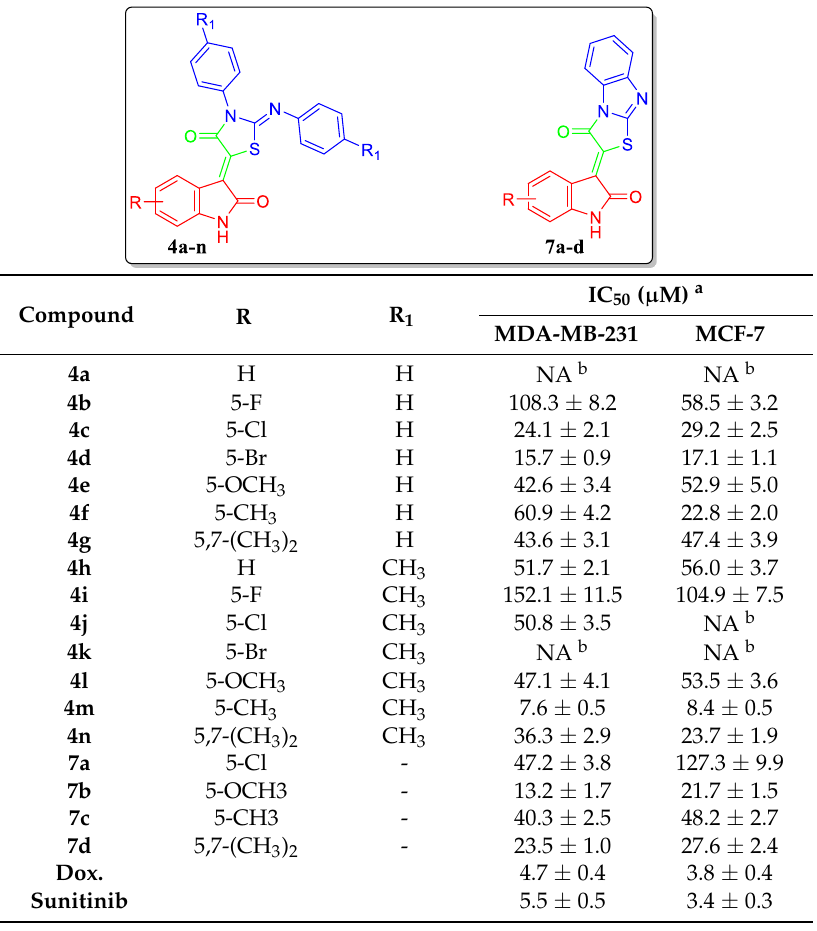
Table 1. In vitro antiproliferative activity of hybrids 4a – n and 7a – d against MDA-MB-231 and MCF-7 breast cancer cell lines.